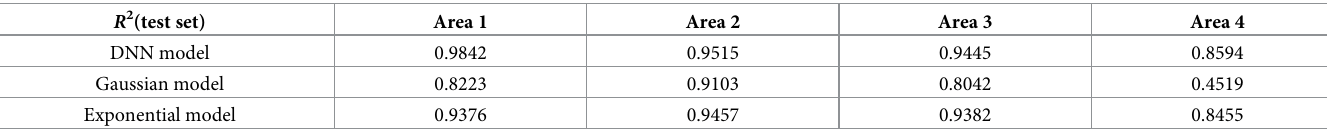
Table 2. R 2 obtained by bringing the 20% of data set as test set into different semivariograms in the four areas. R 2 (test set)